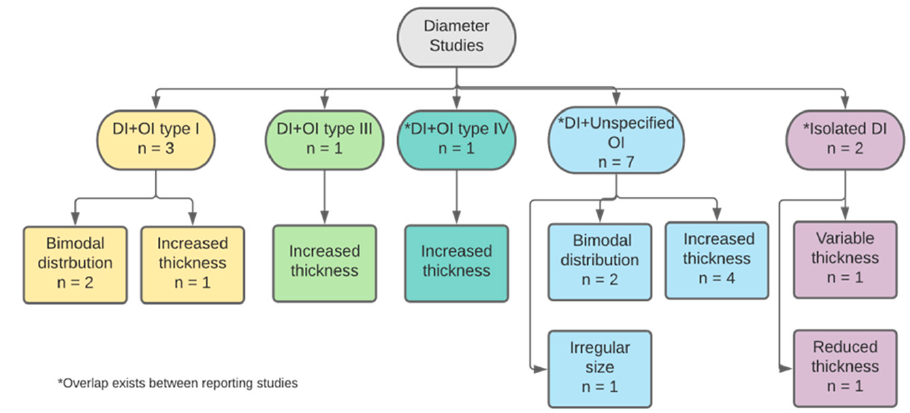
Figure 8. Categorisation of studies reporting on collagen diameter by DI and OI types.